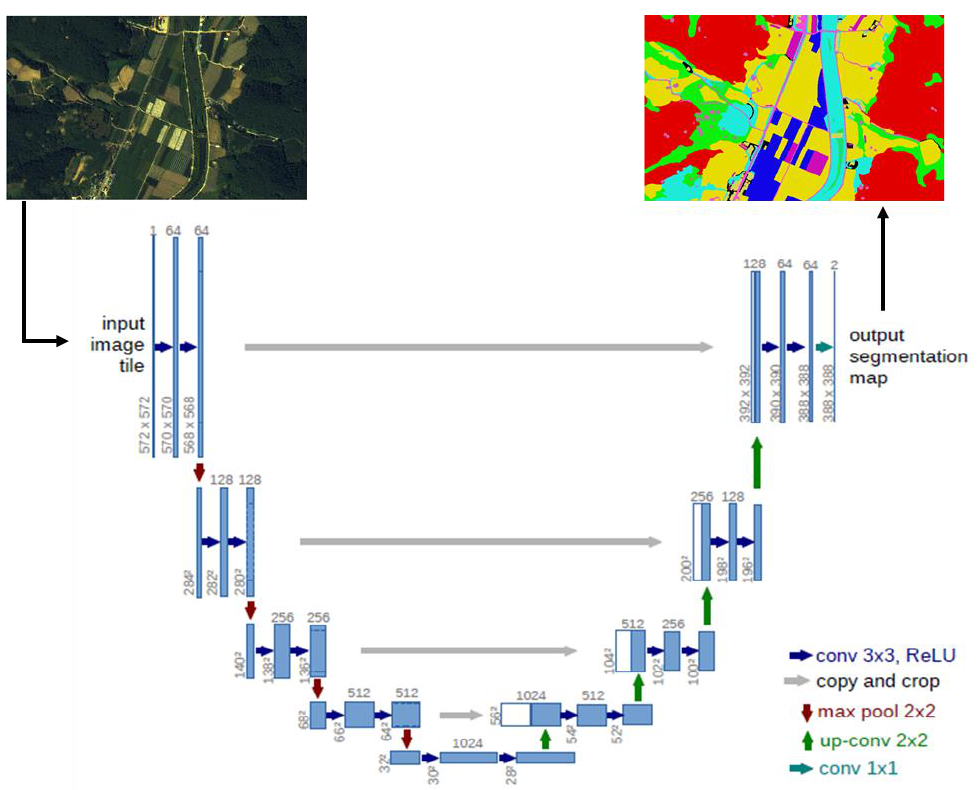
Figure 3. U-Net architecture introduced in [38].